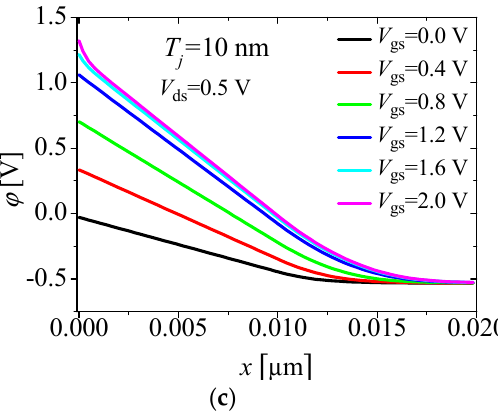
Figure 2. ( a ) G TAT contour plot at V gs = 0 and V ds = 0.5 V for an LTFET with T j = 10 nm. ( b ) G TAT extracted along the cutline in Figure 2a, for V gs = 0–2 V with ∆ V gs = 0.4 V. ( c ) Potential along the cutline of Figure 2a at different V gs s for V ds = 0.5 V and T j = 10 nm.